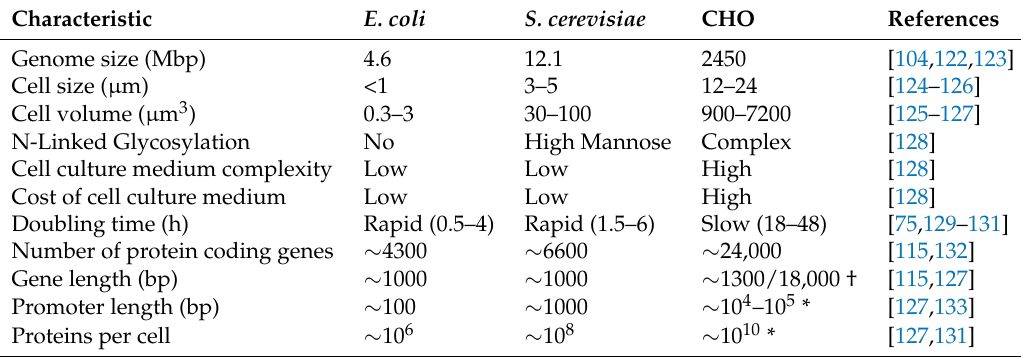
Table 2. Comparison of the three major platforms for biopharmaceuticals